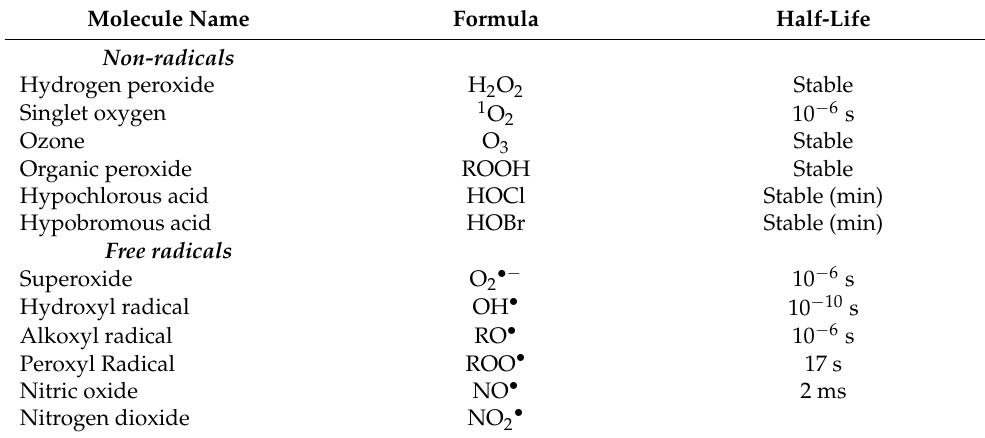
Table 2. Types of most common reactive oxygen species (ROS) generated in plants (adopted from